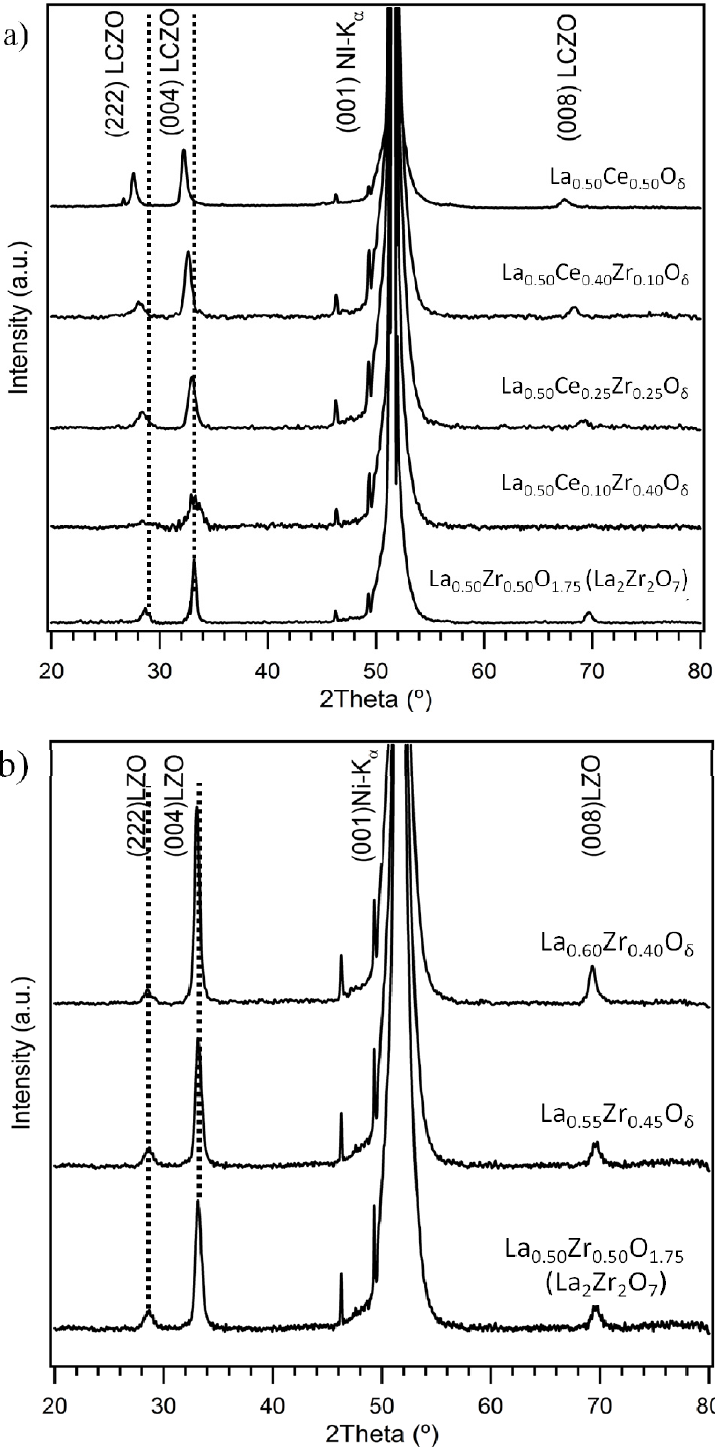
Figure 1. X-ray θ – 2 θ diffraction patterns obtained for ( a ) Cerium doped lanthanum zirconate (LCZO) buffer layers and ( b ) Non-stoichiometric lanthanum zirconate (LZO) buffer